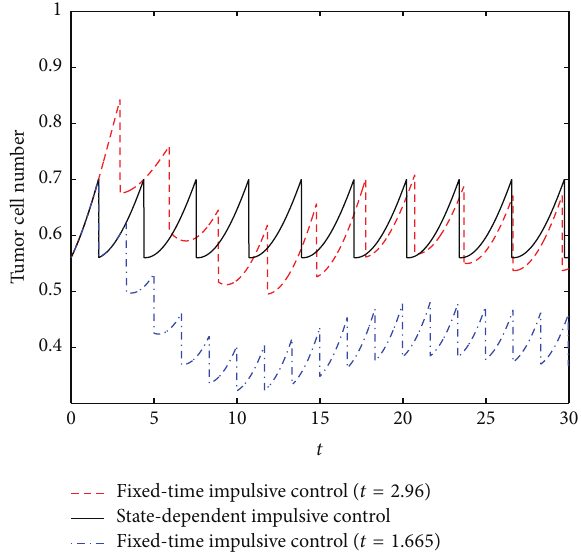
Fixed-time impulsive control ( t = 1.665 ) Figure 5: The comparison of the fixed-time impulsive effect and the state impulsive effect ( 𝑝 = 0.1 , 𝑞 = 0.2 , 𝜏 = 0.22 , 𝐸(0) = 1.58 , and 𝑇(0) = 0.56